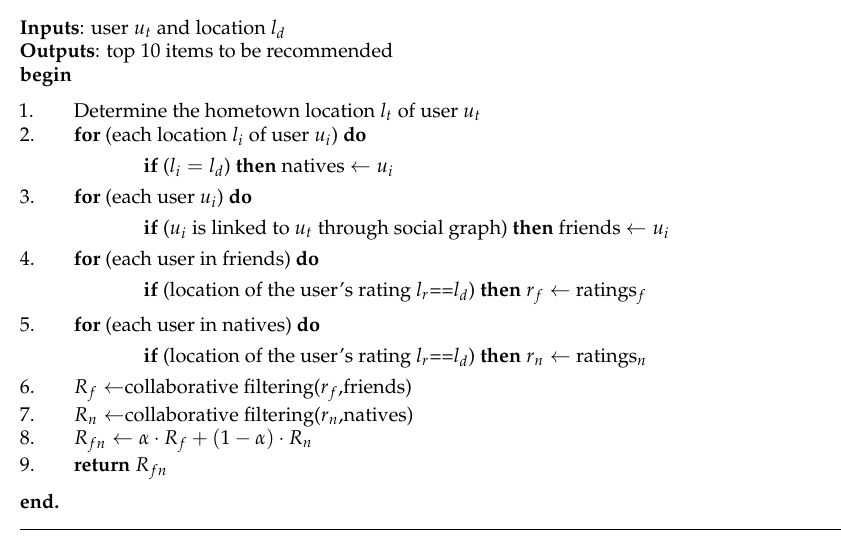
Figure 3. Friend-And-Native-Aware Approach For Collaborative Filtering (FANA-CF)